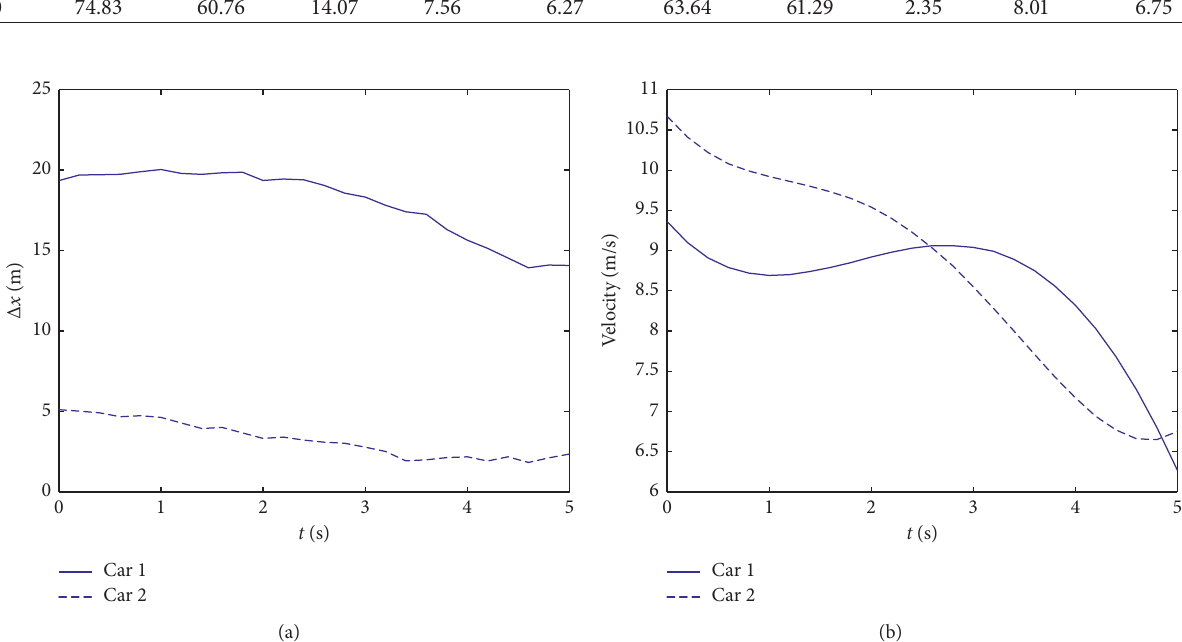
Figure 2: Traffic data of car 1 and car 2: (a) headway-time curves of car 1 and car 2; (b) velocity-time curves of car 1 and car